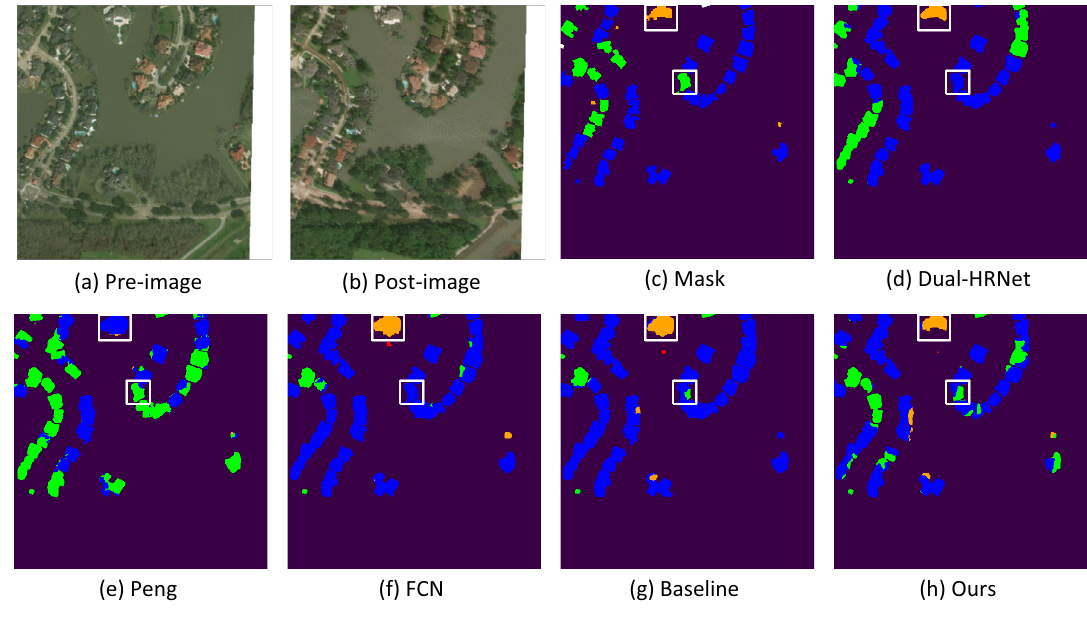
Figure 9. Classification of building damage in Hurricane-Harvey.